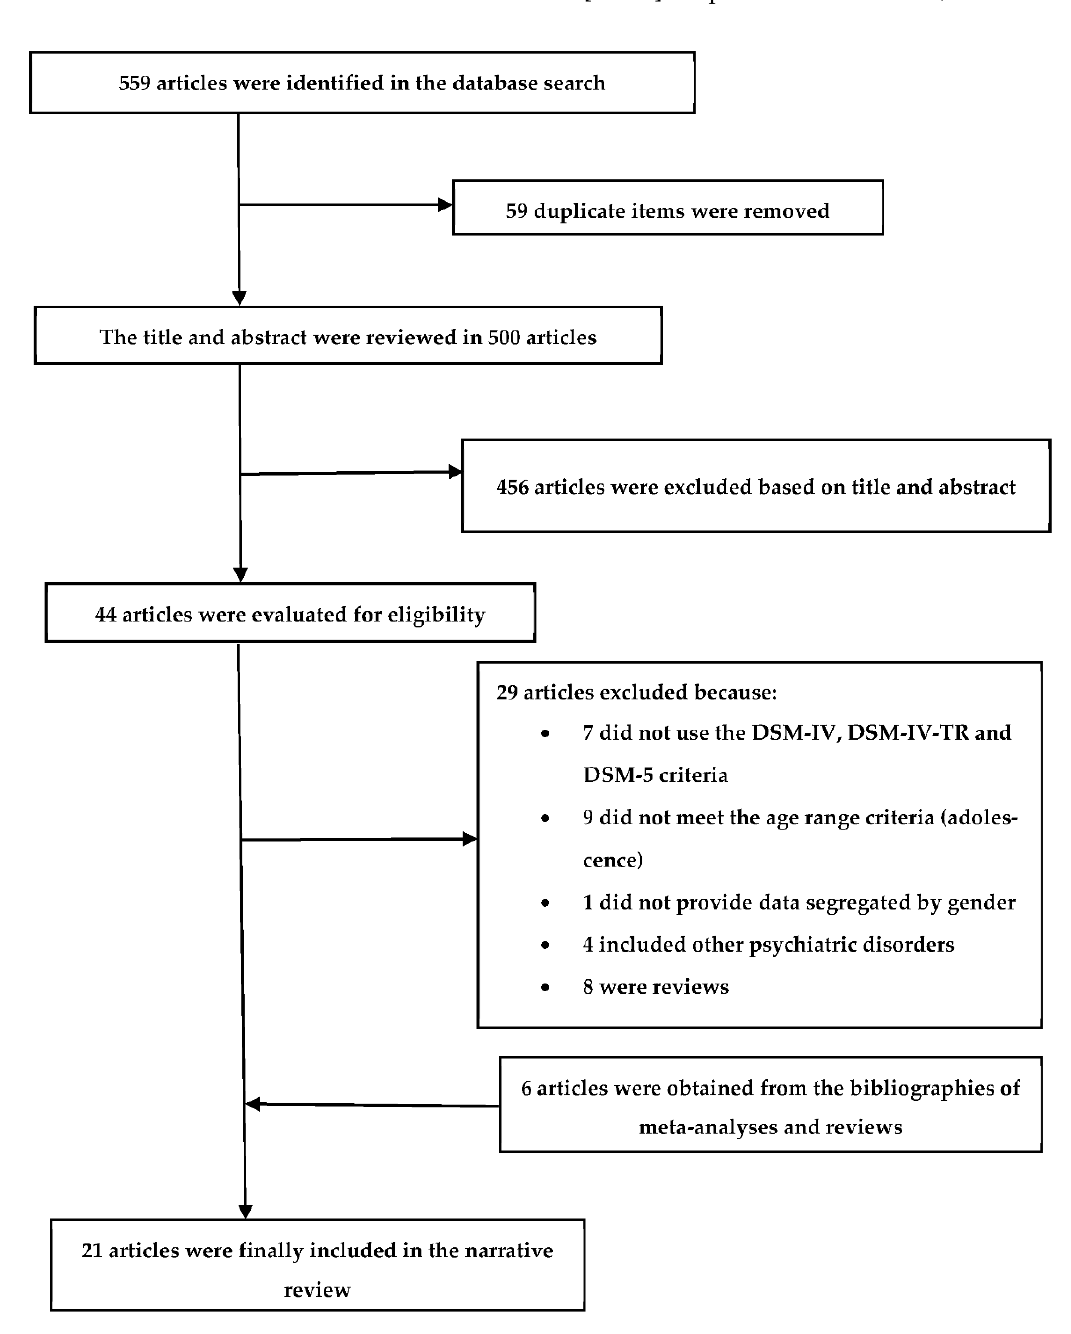
Figure 1. Flowchart of the article selection process.